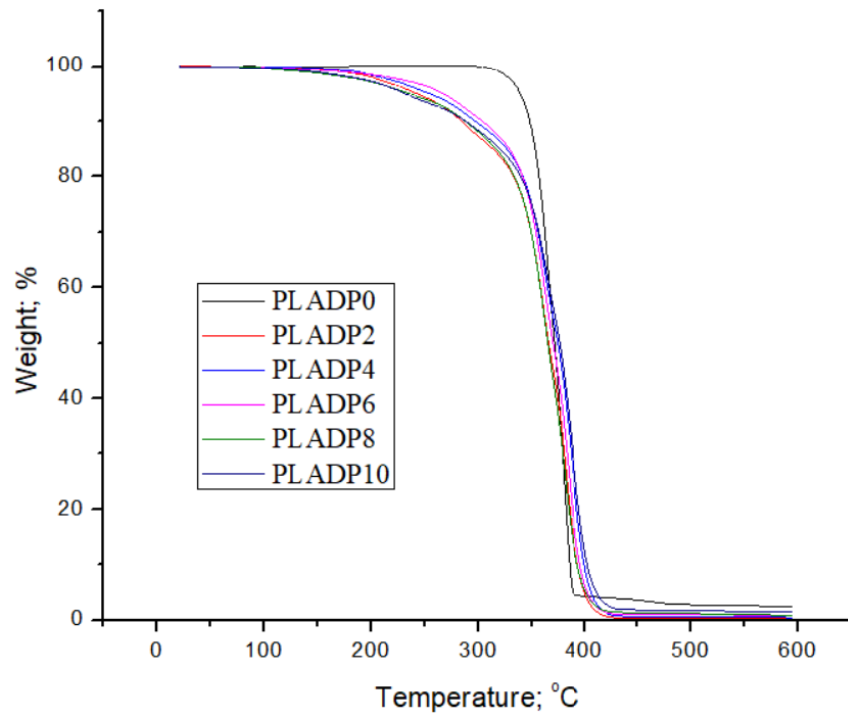
Figure 7. Thermogravimetric curves of pure PLA and PLA – date pit composites.